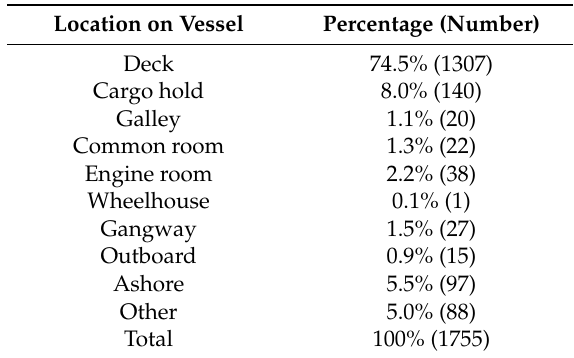
Table 4. Location of injuries on the vessels in the period 1998–2016.